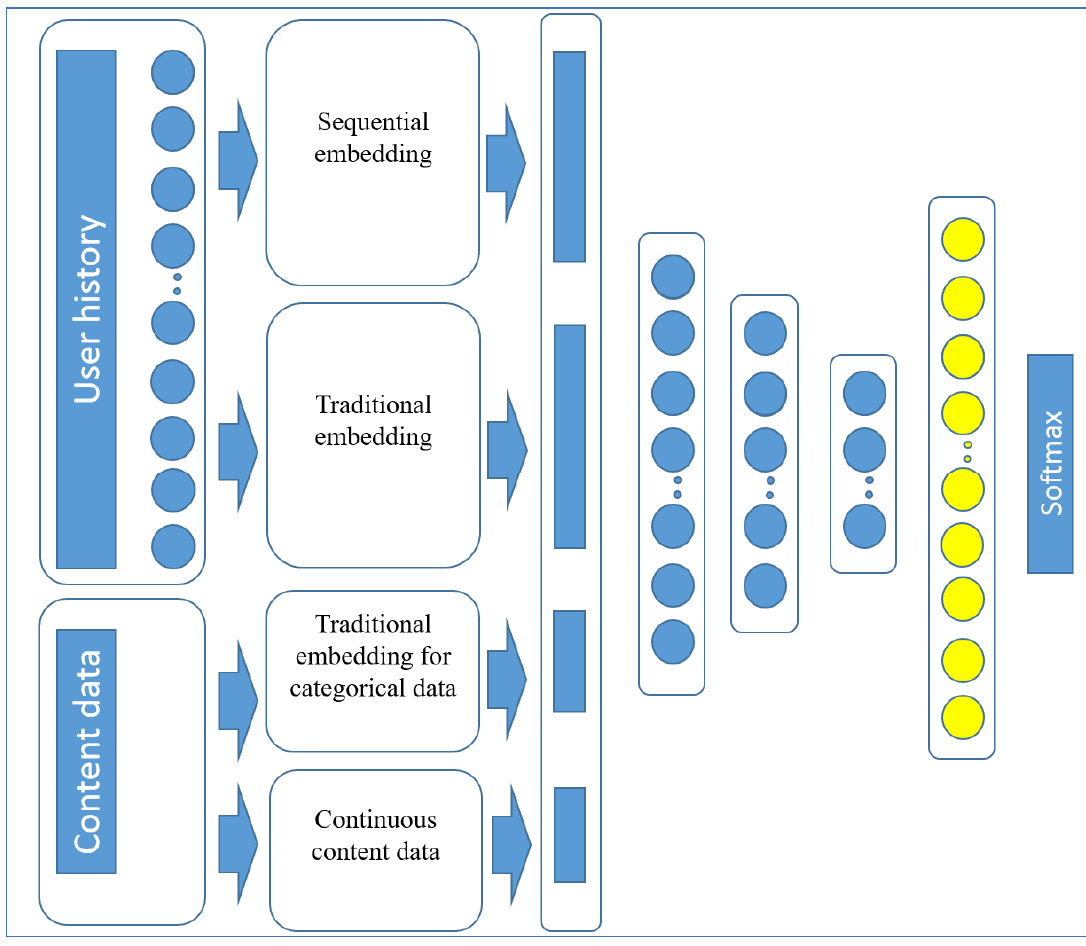
Figure 5. Structure of deep-sequence–aware recommendation.